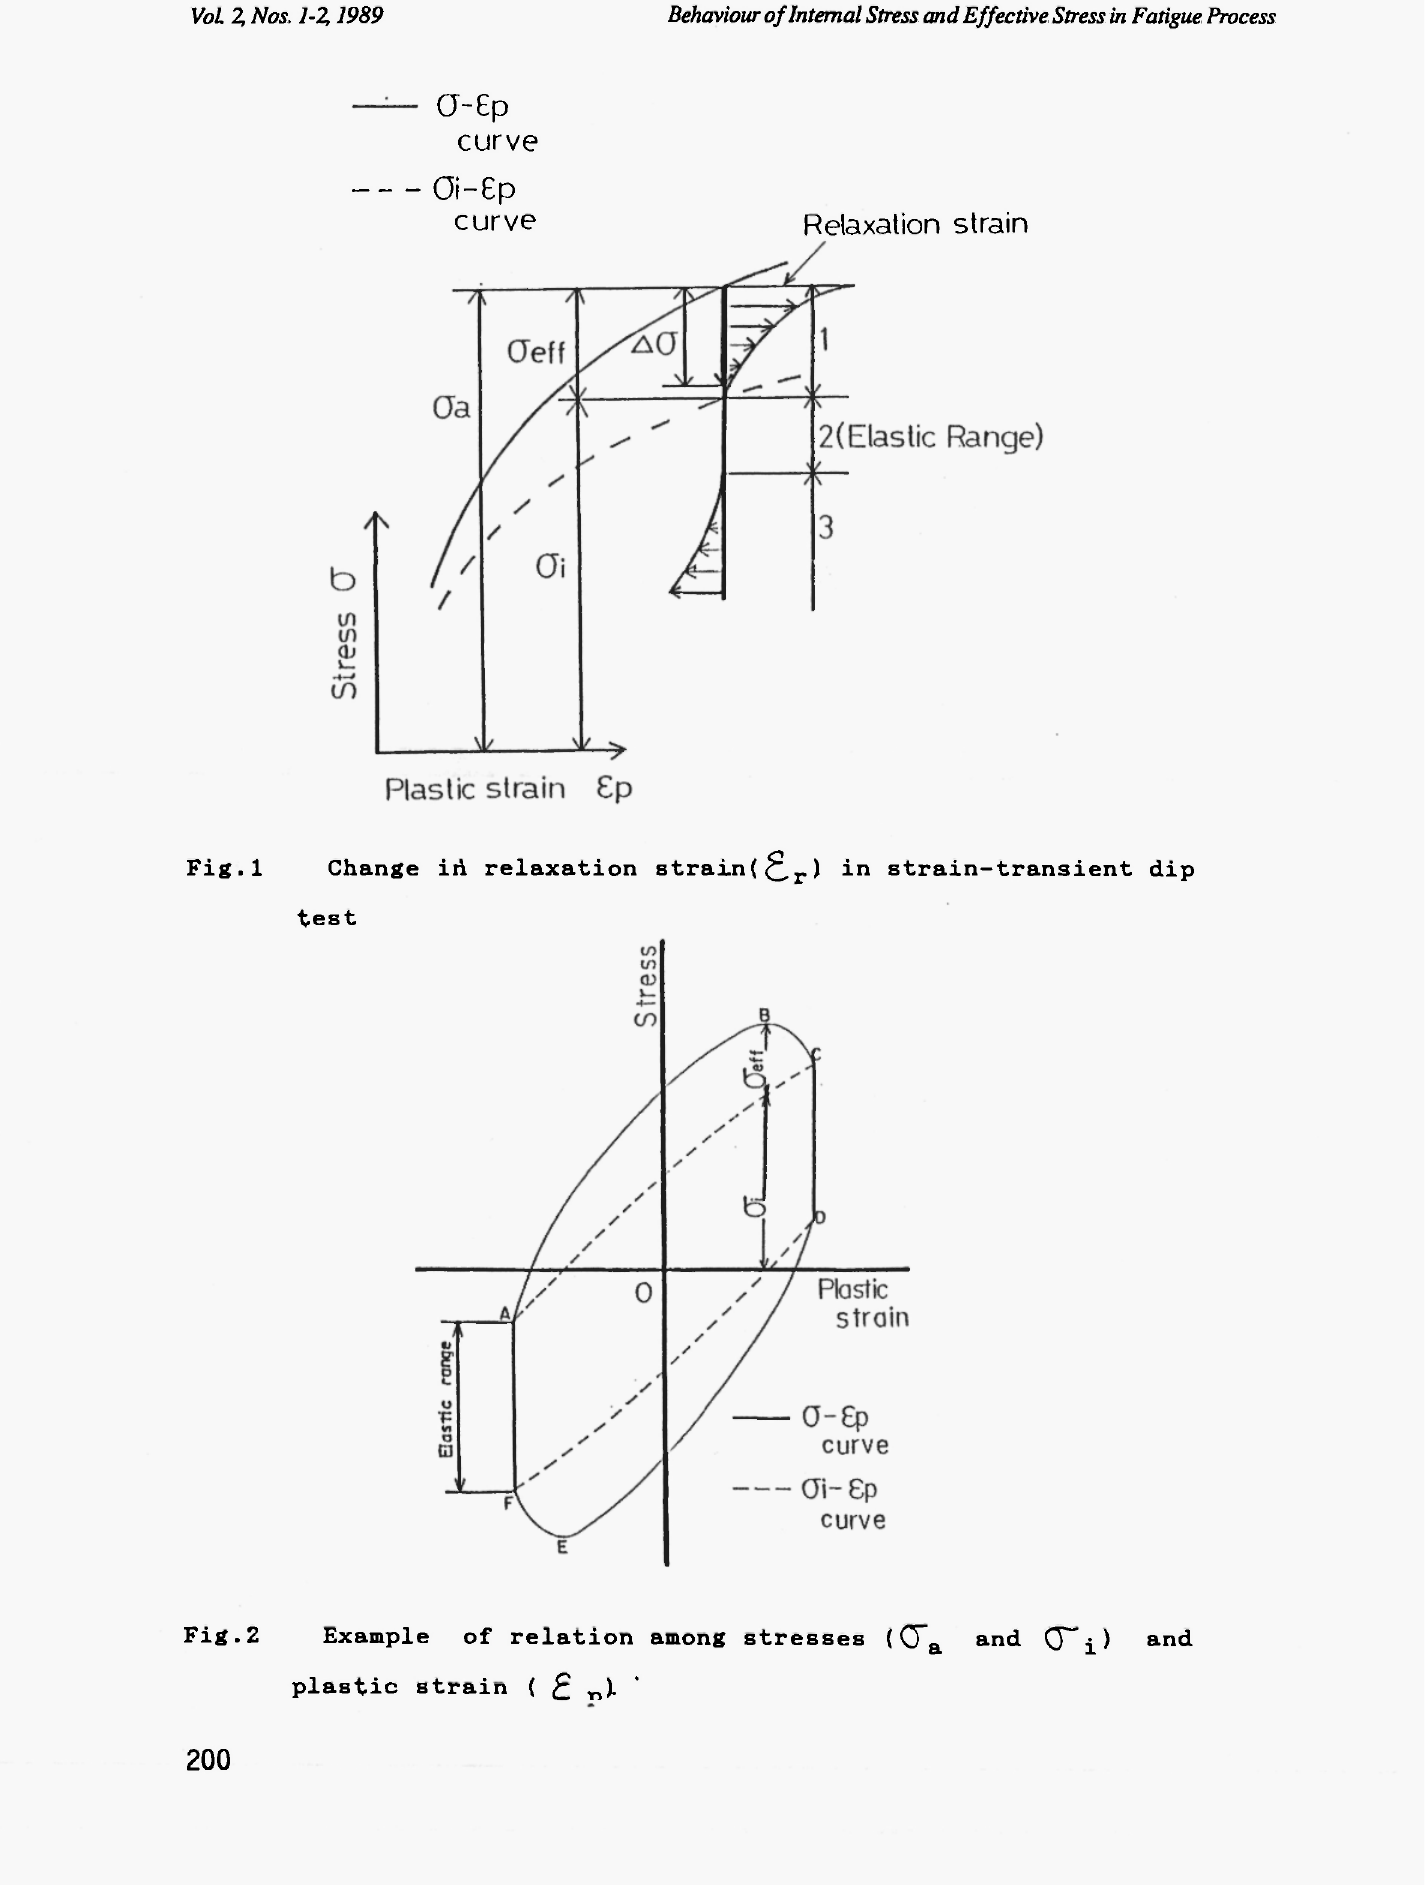
Fig.l Change ΐή relaxation strain(^, r ) in strain-transient dip test